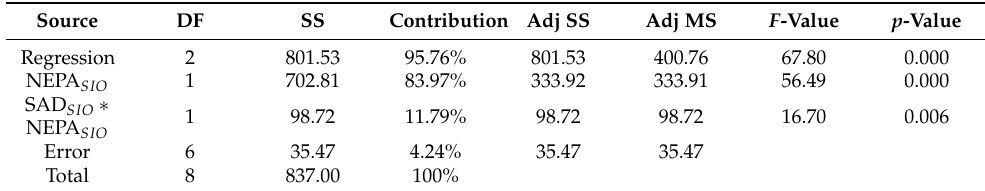
Table 6. ANOVA results for the Stay in the office PLSR